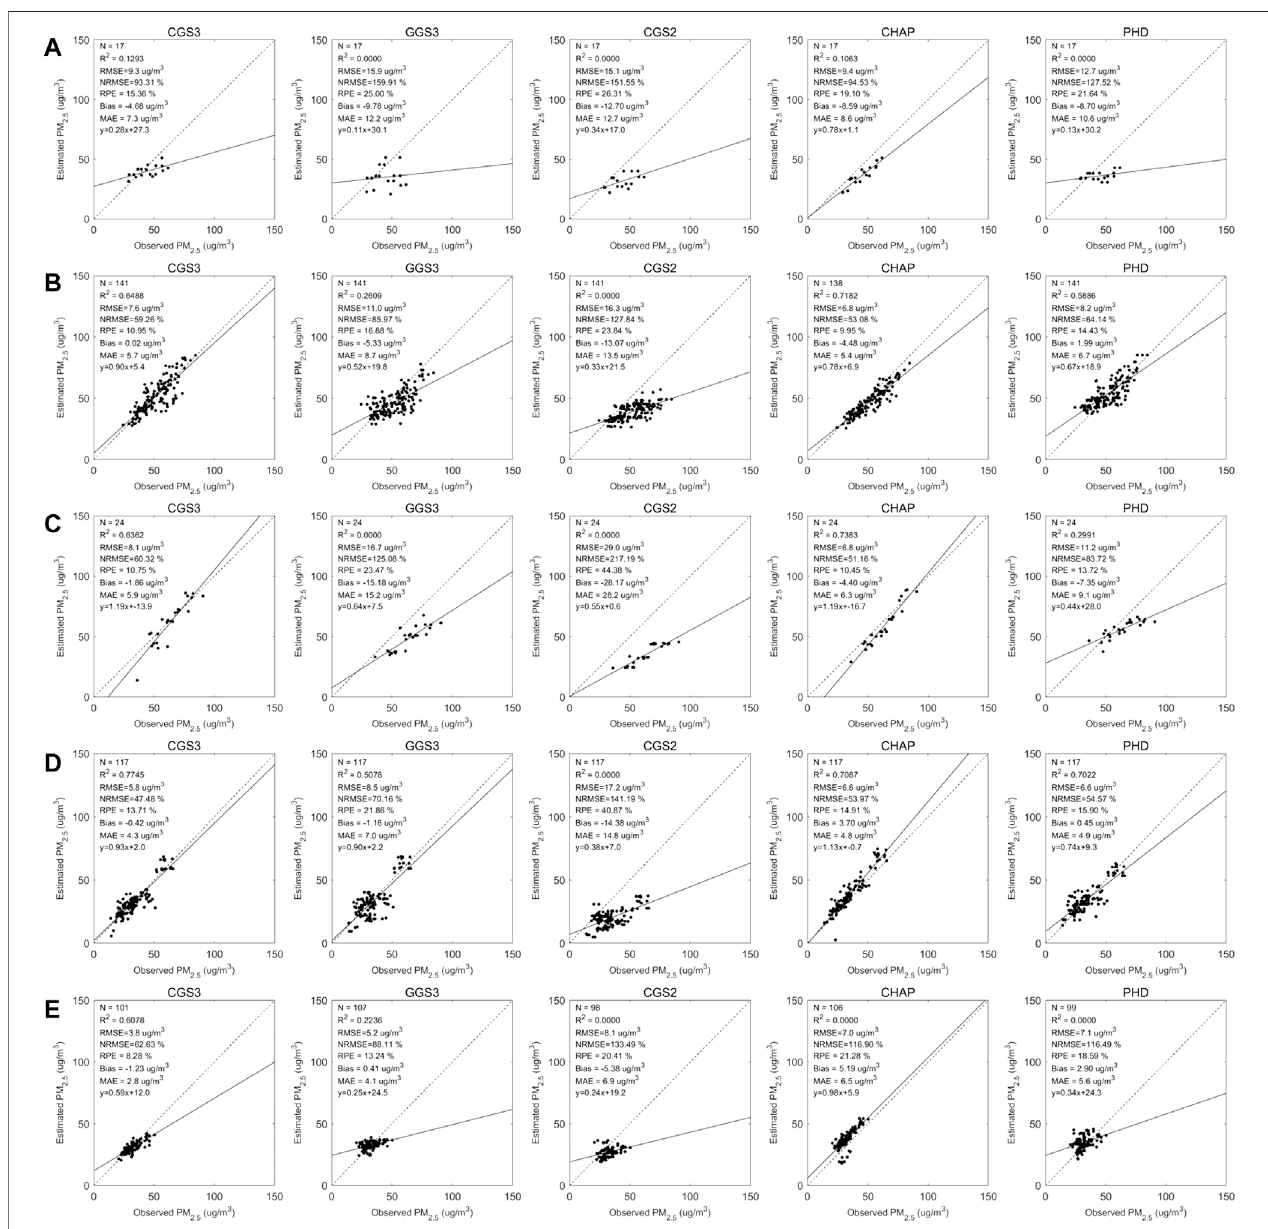
FIGURE10| Scatterplotsof fi ttingand cross-validatingresults intheareas withsigni fi cantdifferences.P.S. (A – E) areareas withsigni fi cantdifferencesin Figure9 .